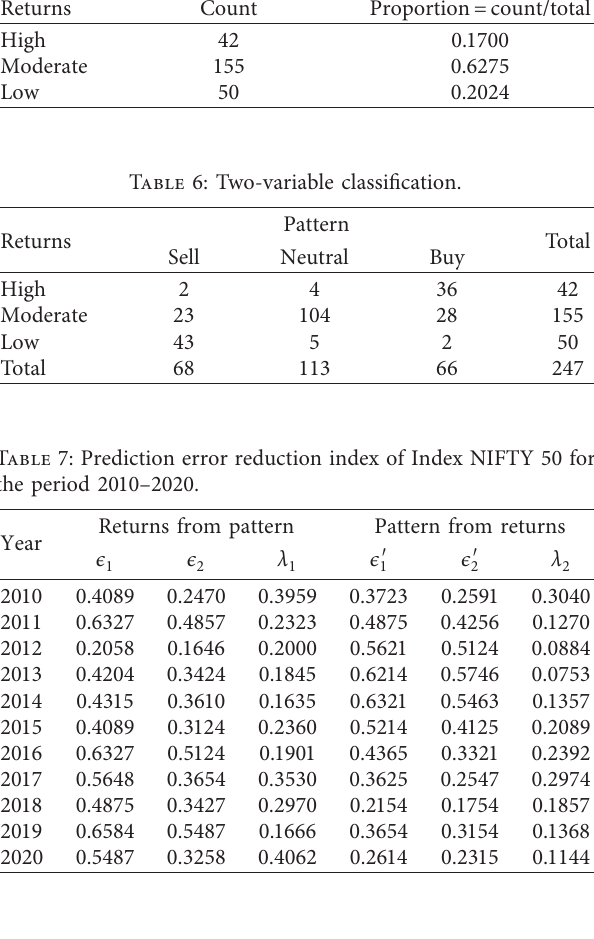
Table 9: Prediction error reduction index of Index NIFTY-IT for